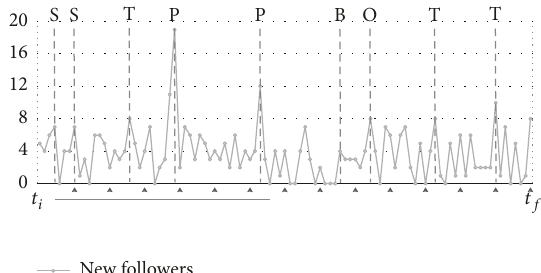
Figure 2: The beginning ( 𝑡 𝑖 ) and the conclusion ( 𝑡 𝑓 ) of the accomplished